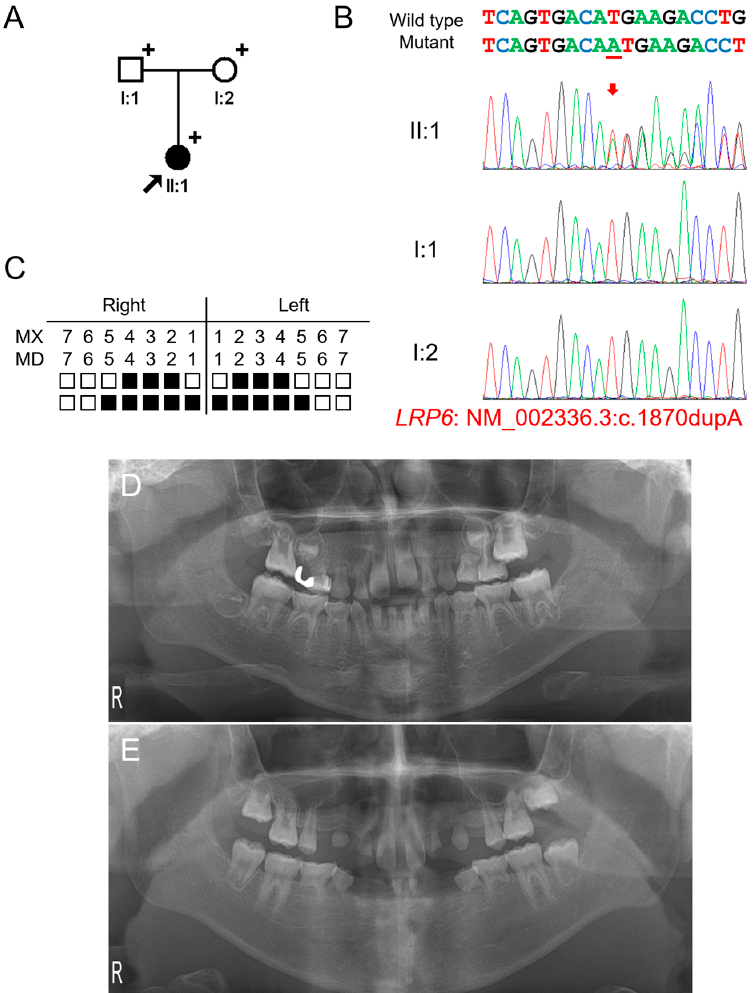
Figure 1. Pedigree, chromatograms, and panoramic radiographs of family 1. ( A ) Pedigree of family 1. Black symbols indicate affected individuals, and the proband is indicated by a black arrow. Plus signs above the symbols indicate participating individuals. ( B ) Sequencing chromatograms of the participating individuals of family 1. Wild-type and mutant nucleotide sequences are shown above the chromatograms. Nucleotide affected by the mutation is underlined. The location of the mutation is indicated with a red arrow. Individual identifications are indicated on the left side of each chromatogram. ( C ) Summary chart of the missing teeth of the proband. Black box indicates a missing tooth. Tooth number is shown above the boxes (MX: maxilla, MN: mandible). ( D ) Panoramic radiograph of the proband at age 5 years 11 months shows multiple missing teeth. Maxillary left first molar exhibits ectopic eruption. The maxillary first molars have taurodontism. ( E ) Panoramic radiograph of the proband at age 12 years 5